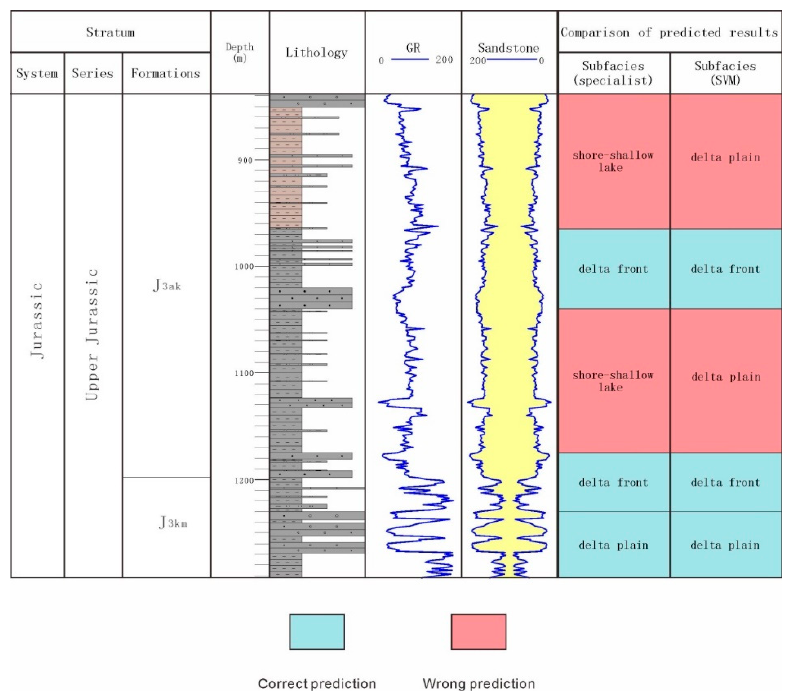
Figure 8. Comparison of the subfacies identification results by the SVM and geologists in well ARY15.